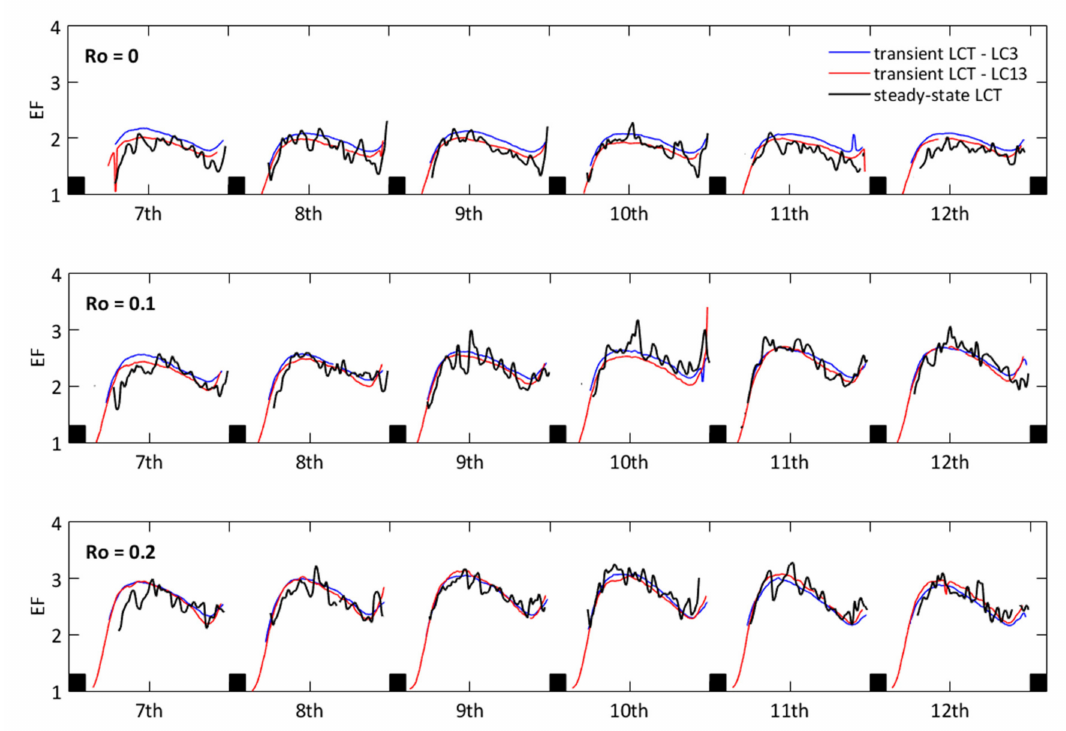
Figure 13. Enhancement factor